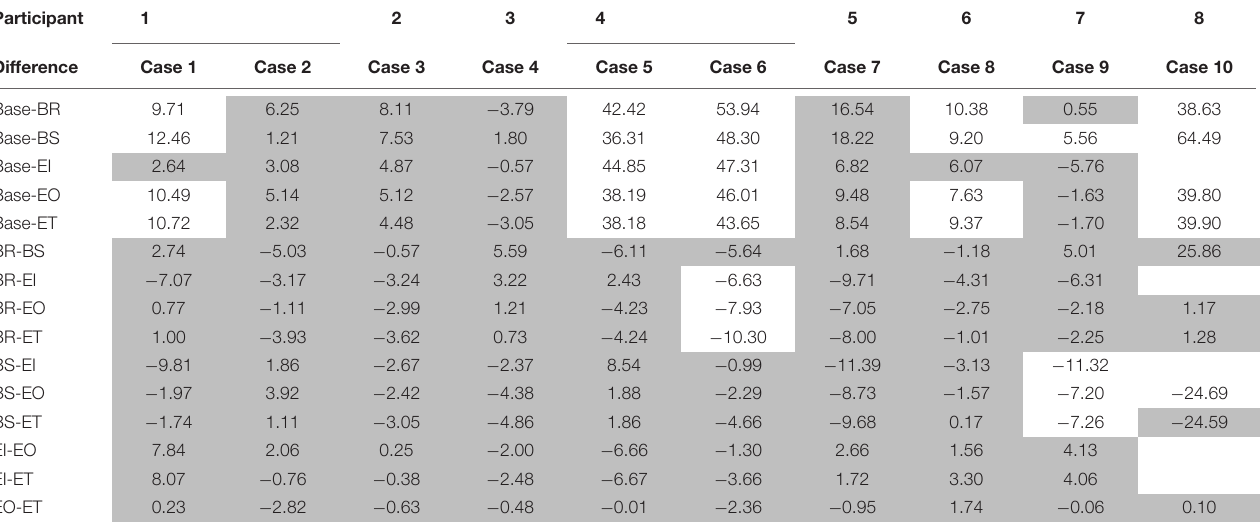
FIGURE 3 | Mean heart rate variability responses to EVA-like tasks (Hill, 2019). TABLE 7 | Differences in heart rate variability responses to EVA-like tasks (Hill,